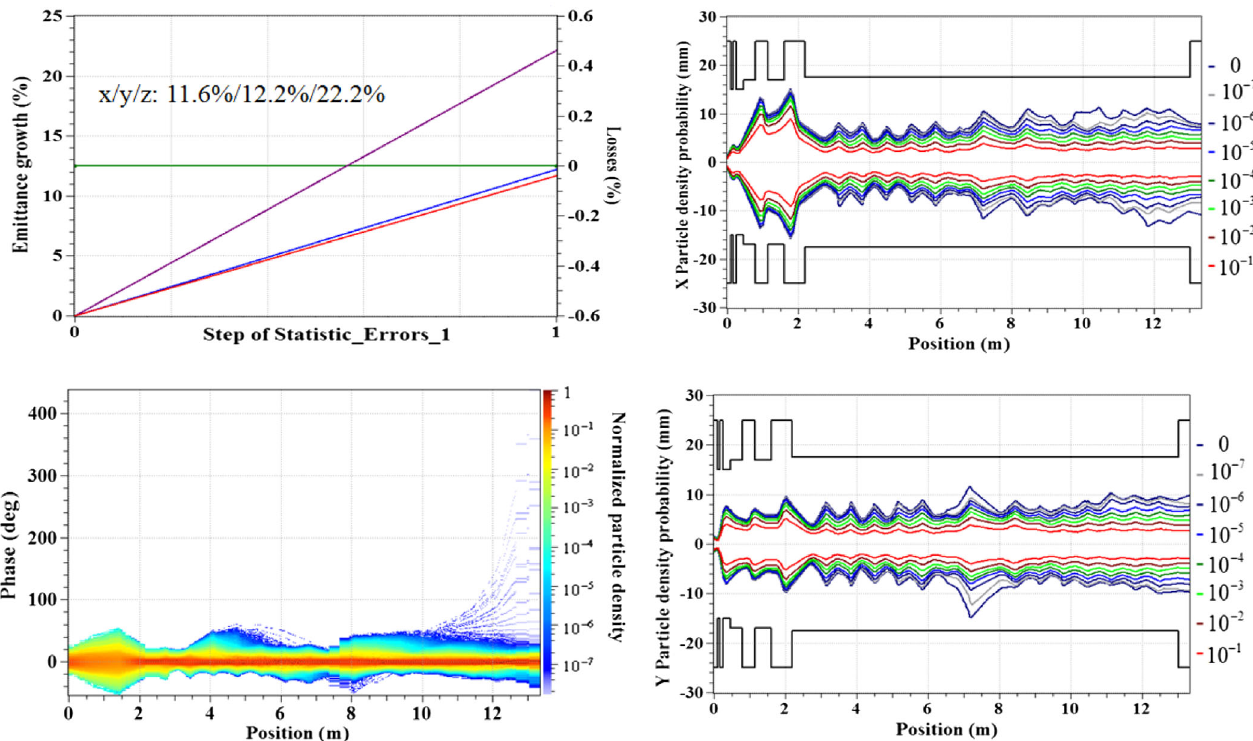
FIG. 21. The normalized rms emittance growth (left upper graph), the transverse particle density (right graphs) and longitudinal power density (lower left graph) with doubled rf errors and misalignment and corrections.